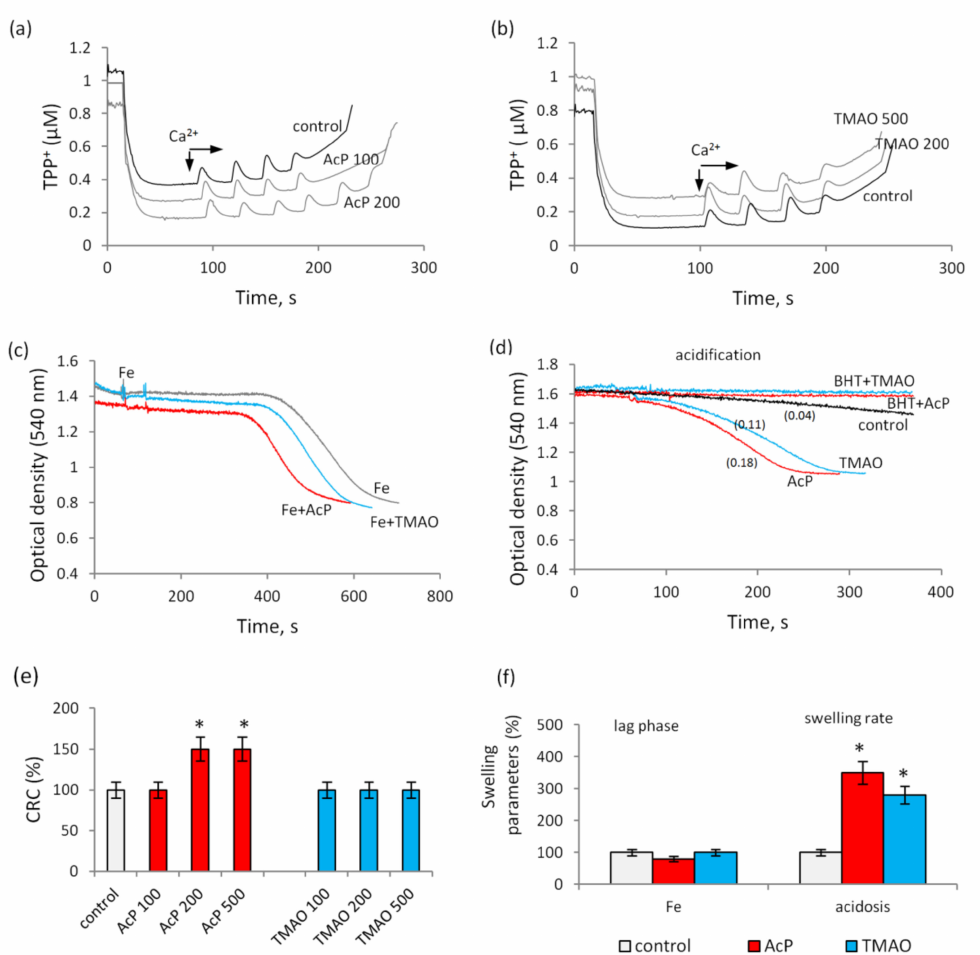
Figure 6. Influence of TMAO and AcP on the MPTP opening induced by calcium ions and on swelling activated by iron ions and medium acidification. MPTP opening in the course of successive additions of 25 µ M CaCl 2 in the presence of AcP ( a ) and TMAO ( b ) at indicated concentrations; iron-activated swelling in the presence of AcP and TMAO at concentrations of 200 µ M ( c ); swelling activated by acidification (pH 6.7) in the presence of AcP and TMAO at a concentration of 100 µ M and its elimination by BHT, the swelling rate ( ∆ /min) is indicated in parentheses ( d ); calcium retention capacity at different AcP and TMAO concentrations (100–500 µ M) ( e ) and swelling parameters in the presence of AcP and TMAO at concentrations of 100 µ M under iron loading and medium acidification ( f ). Asterisk (*) indicates values that differ significantly from the control values ( p < 0.05). Both metabolites had insignificant effects on iron-activated mitochondrial